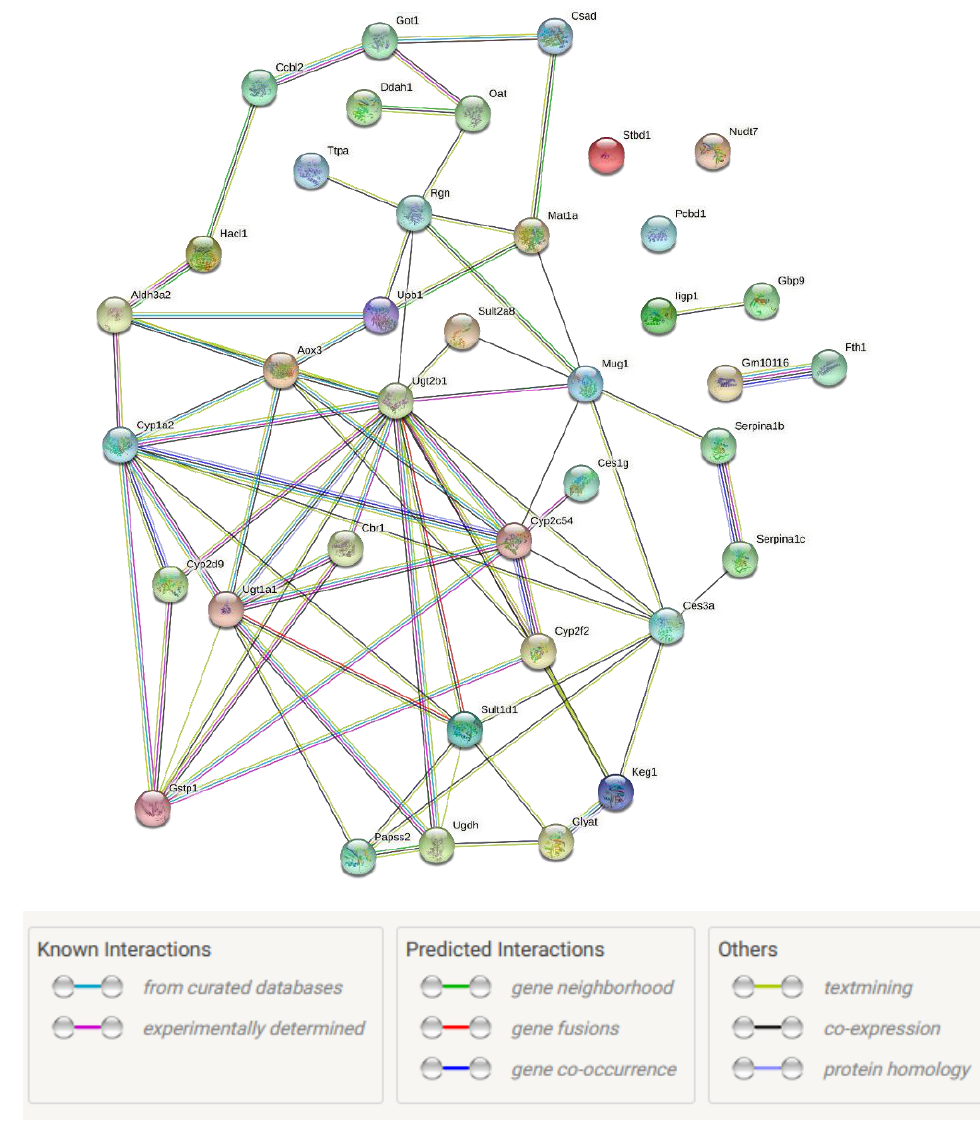
Figure 6. Protein interaction network generated by String-DB analysis of the differentially abundant proteins listed in Figure 5, highlighting the interconnectedness of these sex-specific proteins. Colours indicate the following.